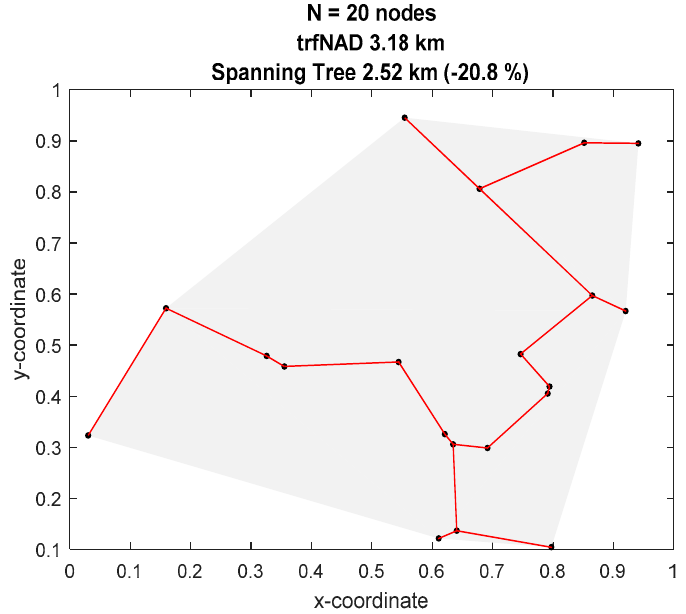
Figure 12. Example Minimum spanning tree.